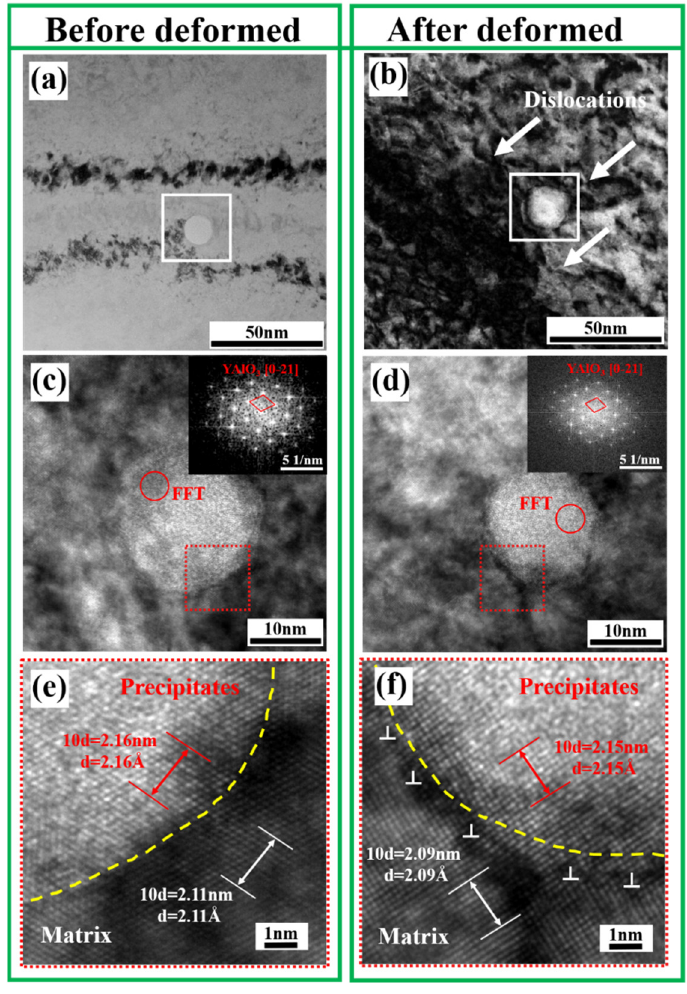
Figure 9. HRTEM results of nano-sized precipitates containing yttrium before and after deformation. ( a , c , e ) Precipitates before deformation; ( b , d , f ) precipitates after deformation.